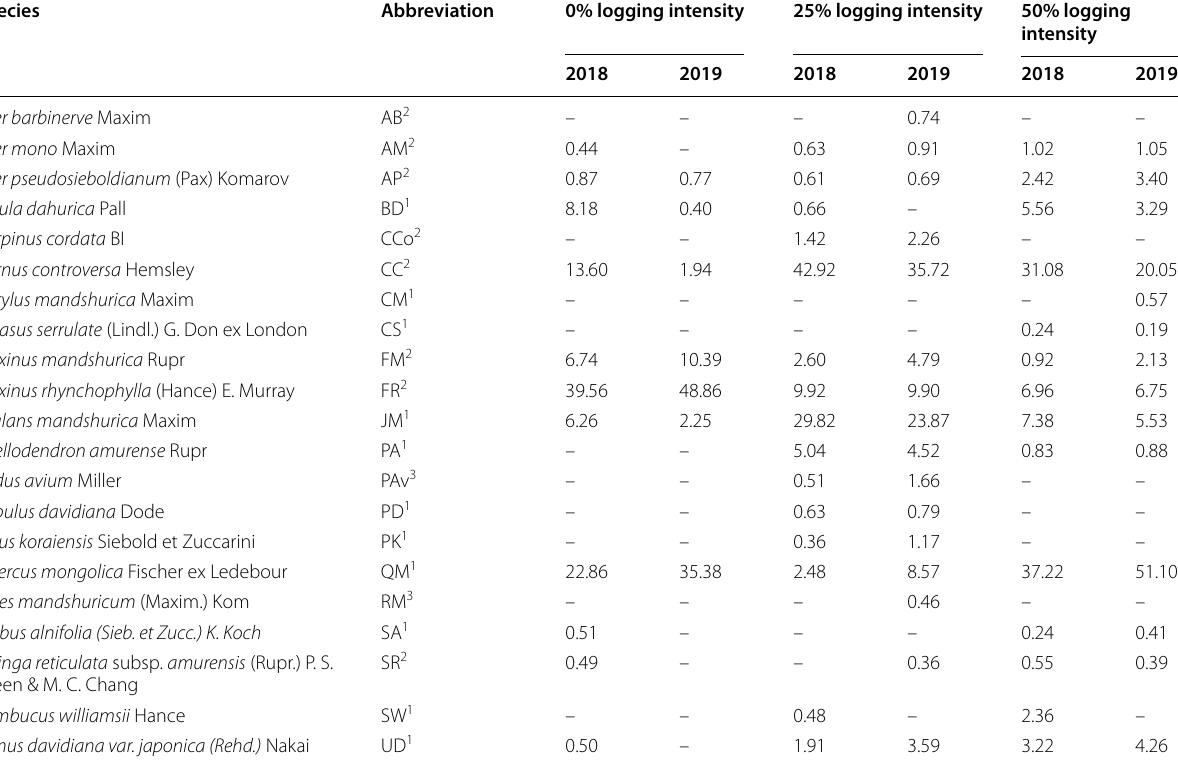
25% logging intensity 25% of the basal area removal; 50% logging intensity = shade tolerance of woody species. 1: shade-intolerant species; 2: intermediate shade-tolerant species; 3: shade-tolerant species (Lu et al.